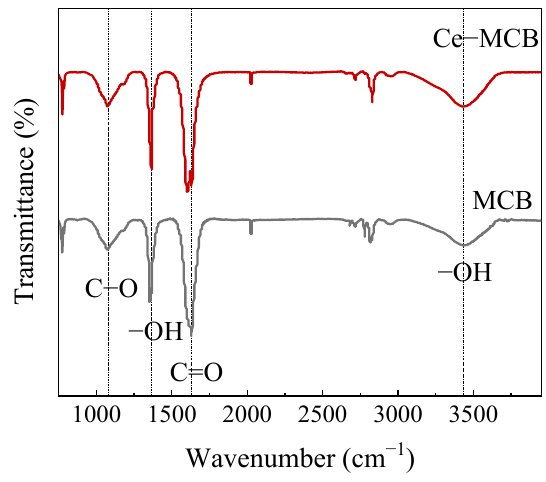
Figure 6. FTIR curves of MCB and Ce-MCB. The hysteresis loops of MCB and Ce-MCB were represented as magnetic properties.